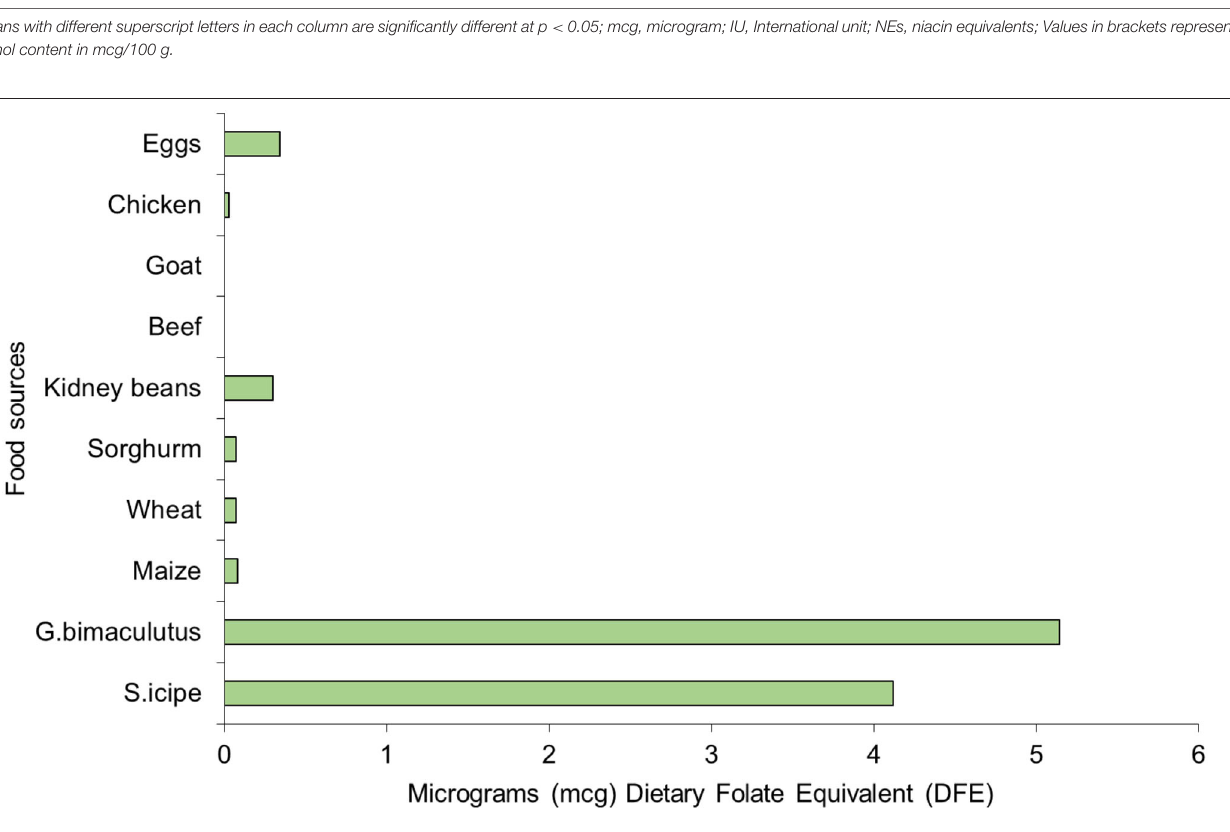
FIGURE 5 | Folic acid content [microgram Dietary Folate Equivalent (mcg DFE)] of Scapsipedus icipe and Gryllus bimaculatus , animal and plant-based sources. Data for plant and animal food sources was extracted from FAO/GoK